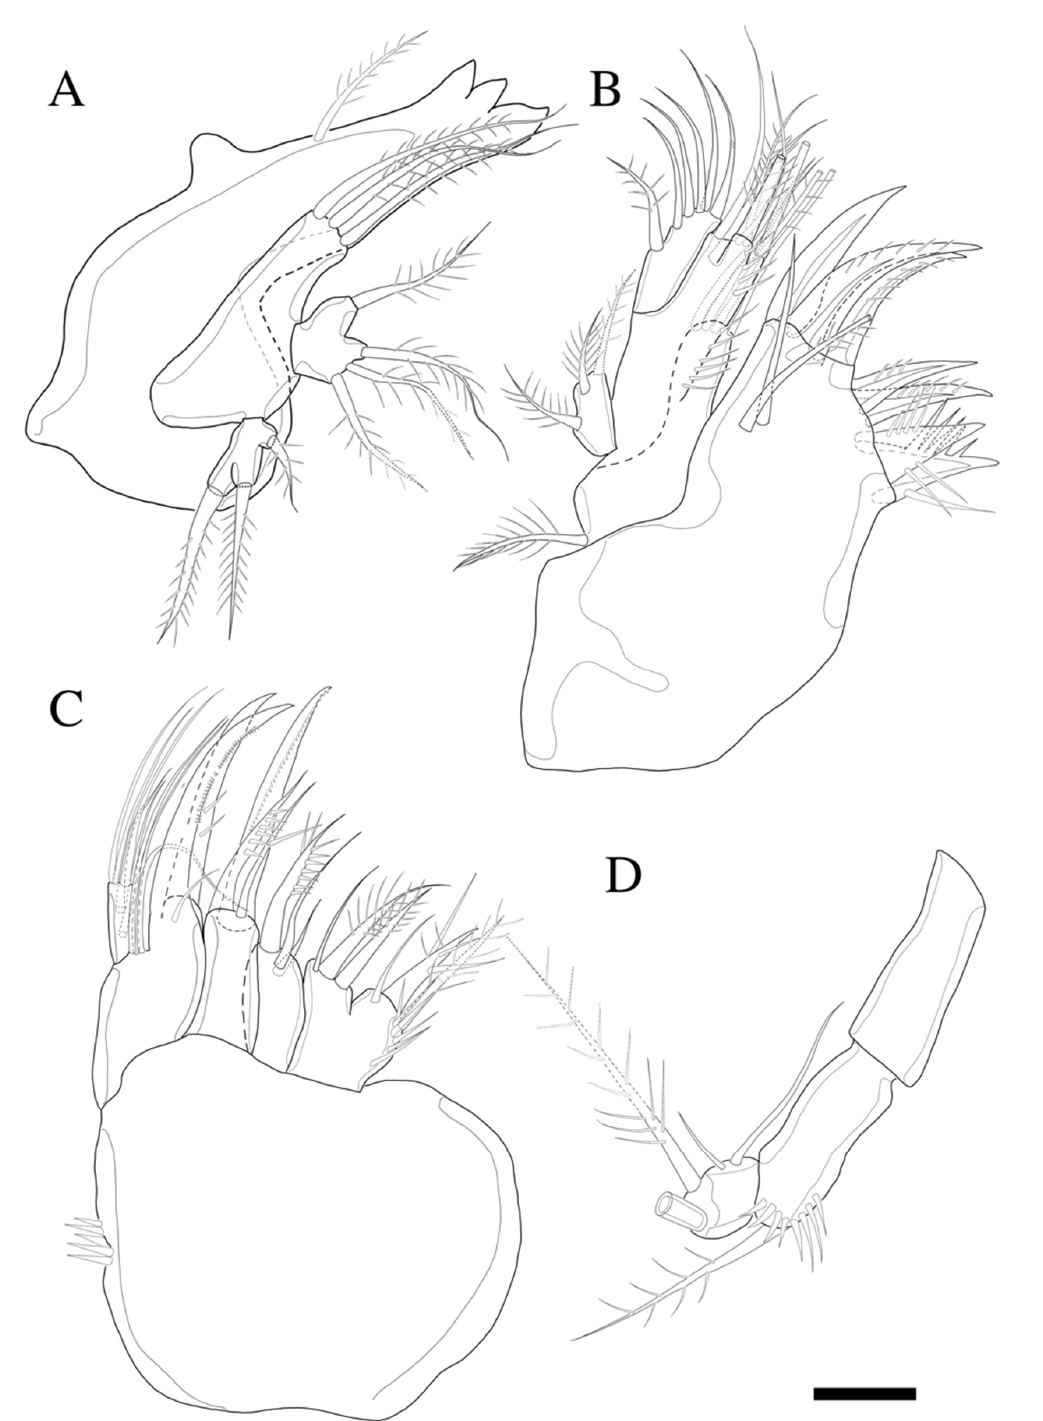
Figure 4. Zosime montagnai sp. nov. ( A ) Mandible; ( B ) Maxillule; ( C ) Maxilla; ( D ) Maxilliped. Scale bar: 10 µm.